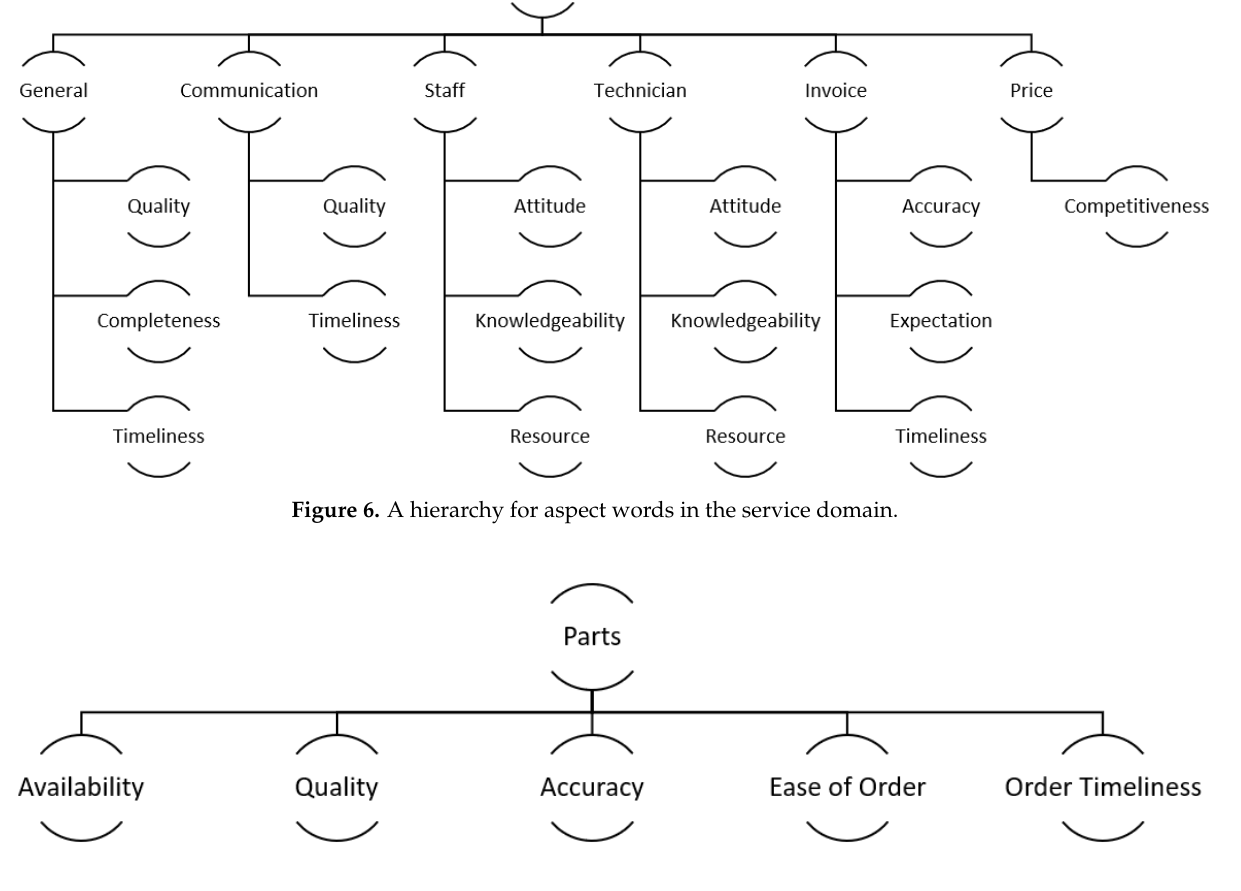
Figure 7. A hierarchy for aspect words in the equipment parts